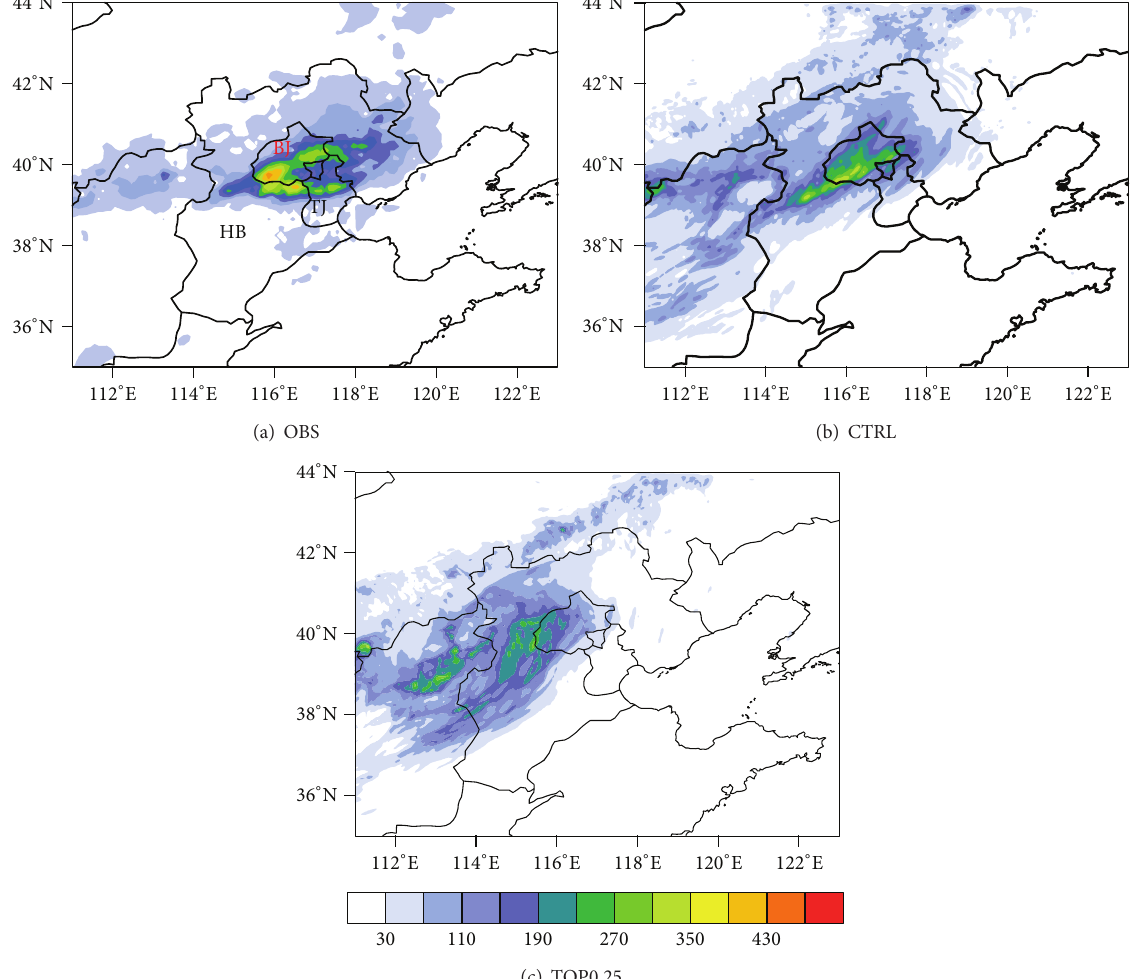
Figure 1: The 24 h accumulated rainfall (unit: mm) from (a) observation, (b) CTRL, and (c) TOP0.25 experiment ending at 0000 UTC 22 July 2012; “BJ” (red), “TJ,” and “HB” indicated Beijing and Tianjin metropolitan city and Hebei province,